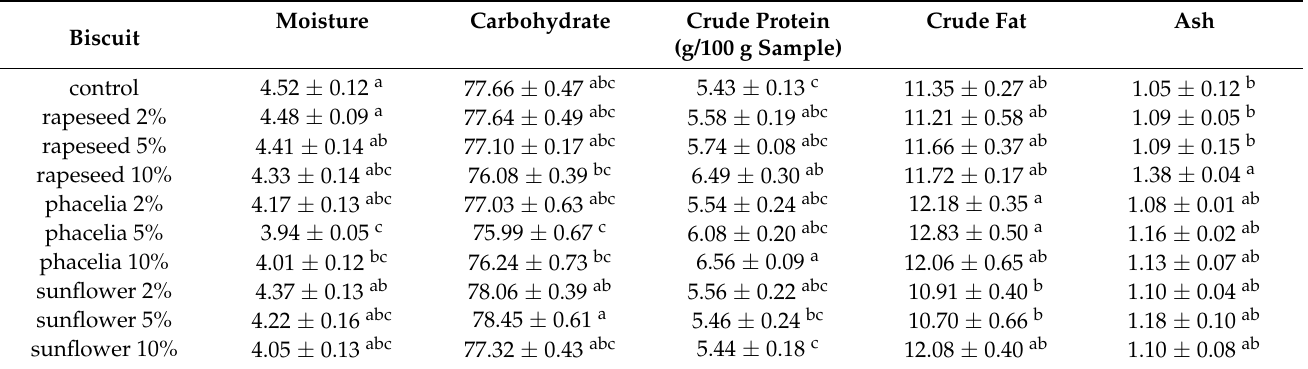
Table 2. Macronutrient composition of pollen enriched biscuits (%).